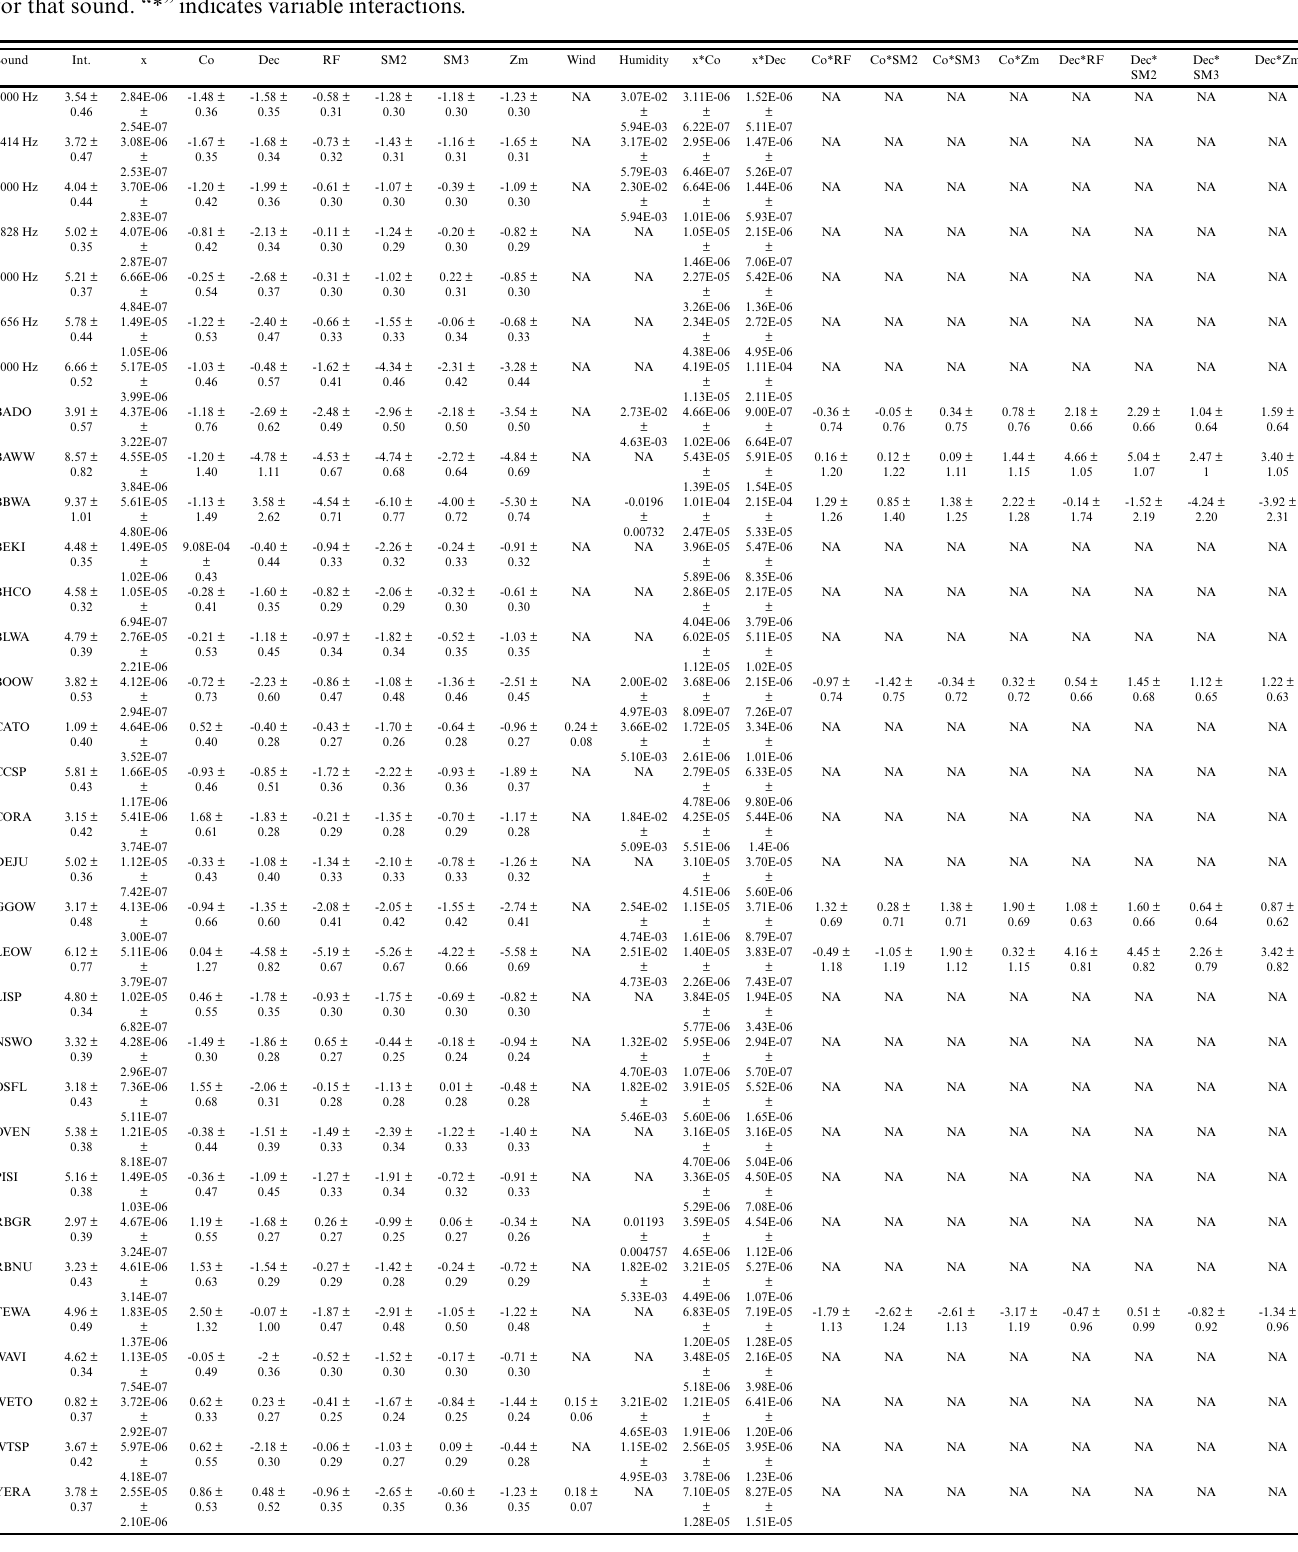
Table 4 . Model coefficients (recorder type, habitat type, distance, interactions between habitat type and distance, wind, humidity) for the top AIC-ranked model predicting probability of detecting each species and tone with RiverForks (RF), SM2, SM3, and Zoom (Zm) recorders, in listening trials conducted at 20 transects near Calling Lake and Lac La Biche, Alberta, Canada in 2014. “x” is equal to -(Distance)2. The reference level for coniferous (Co) and deciduous (Dec) habitat is roadside habitat. “NA” means that variable was not included in the top model for that sound. “*” indicates variable interactions.